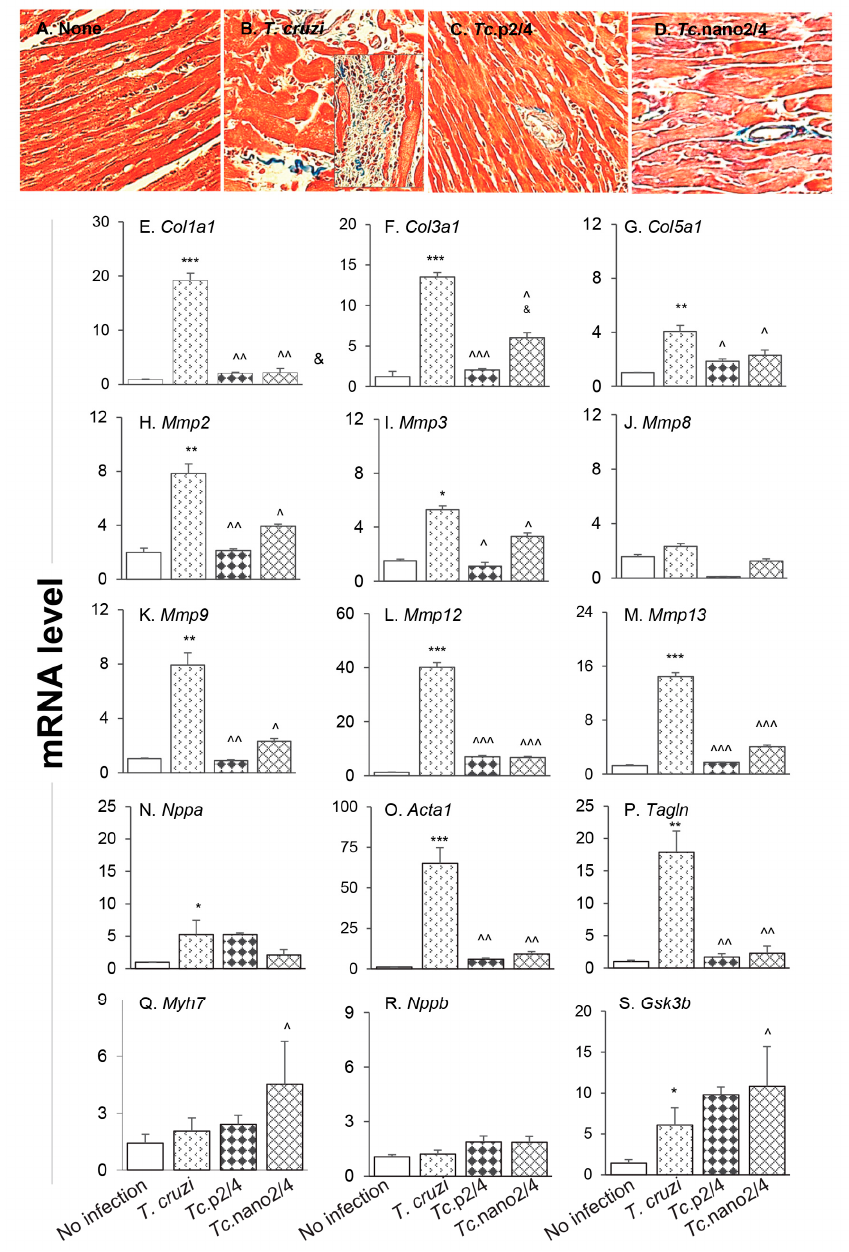
Figure 5. Hypertrophy and fibrosis in Chagas mice (± nano-immunotherapy). Mice were infected, treated, and euthanized as described in Figure S1. ( A–D ) Representative images of Masson’s trichrome staining of heart tissue sections from non-infected ( A ), infected ( B ), Tc .p2/4 ( C ), and Tc. nano2/4 ( D ) groups of mice are shown (magnification: 20X). Fibrosis scores were calculated from n = 3 mice per group, 2–3 tissue sections per mouse, and at least 9 microscopic fields per section, and are presented in Table 1B. ( E–S ) Heart tissues were subjected to RT-qPCR evaluation of mRNA levels for collagens (E –G ), metalloproteinases ( H–M ), and hypertrophy markers and repair proteins ( N–S ). Gene expression data were normalized to Gapdh and values are presented as mean value ± SD (derived from n = 5 mice per group, duplicate observations per sample). Significance was calculated and annotated as described in Figure 1.